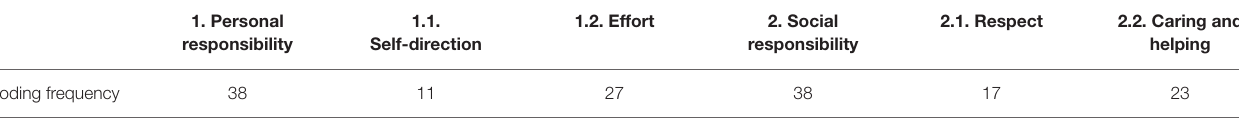
TABLE 6 | Field note coding